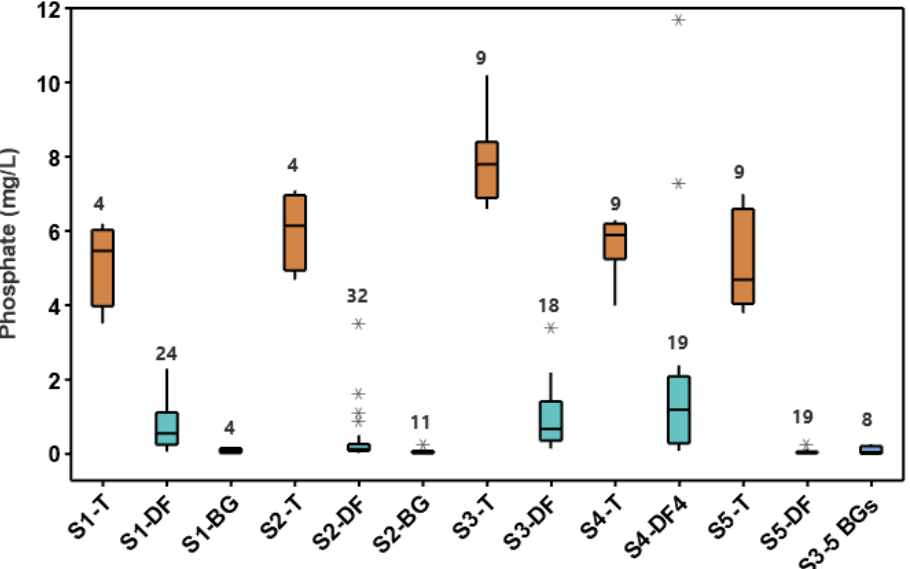
Figure 5. Phosphate concentrations in wastewater sampled from the septic tanks (T), groundwater near the drainfield trenches (DF), and background groundwater (BG) at Sites 1–5. Vertical lines extending from the boxes show minimum and maximum values. Statistical outliers are shown as (*). Number of samples is shown above each box. Background groundwater data from Sites 3 and 4 were pooled and used as background groundwater for Sites 3–5, which are neighboring properties.